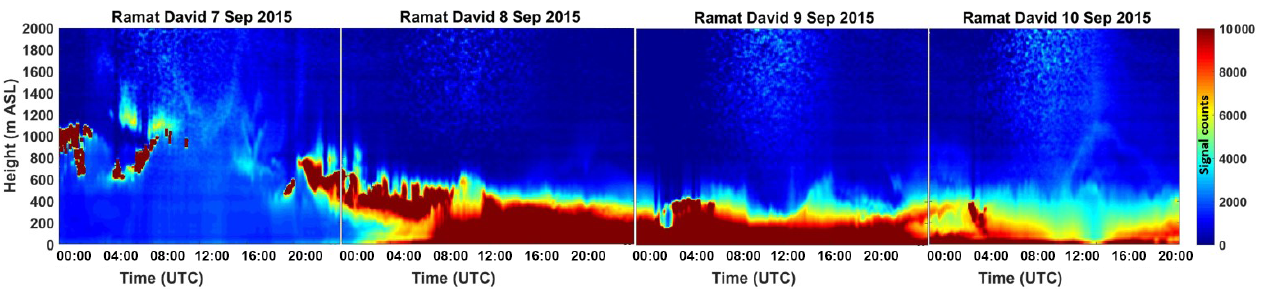
Figure 6. Ramat David ceilometer signal counts plots for 7–10 September 2015. The y axis is the height up to 2000ma.s.l., the x axis is the time in UTC, and the signal count scale ranges between 0 and 10000.